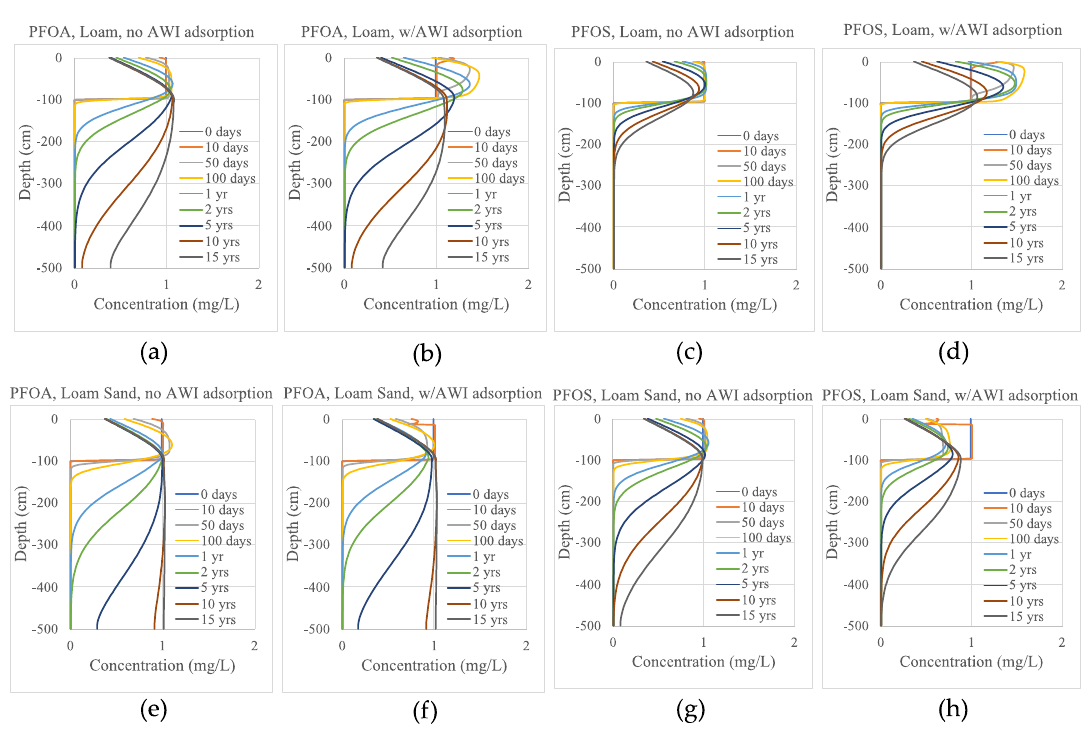
Figure 6. Simulated PFOA (left four figures) and PFOS (right four figures) concentration profiles for unsaturated flow: ( a , b ) PFOA transport within loam, without and with air–water interfacial (AWI) adsorption; ( c , d ) PFOS transport within loam, without and with AWI adsorption; ( e , f ) PFOA transport within loamy sand, without and with AWI adsorption; ( g , h ) PFOS transport within loamy sand, without and with AWI adsorption. Solid phase sorption included in all cases. Table 4. Simulated PFAS arrival times to groundwater at 70 ng / L for soil systems considered. t a,70 —Years (Sorption Simulation No. 1 Soil System PFAS